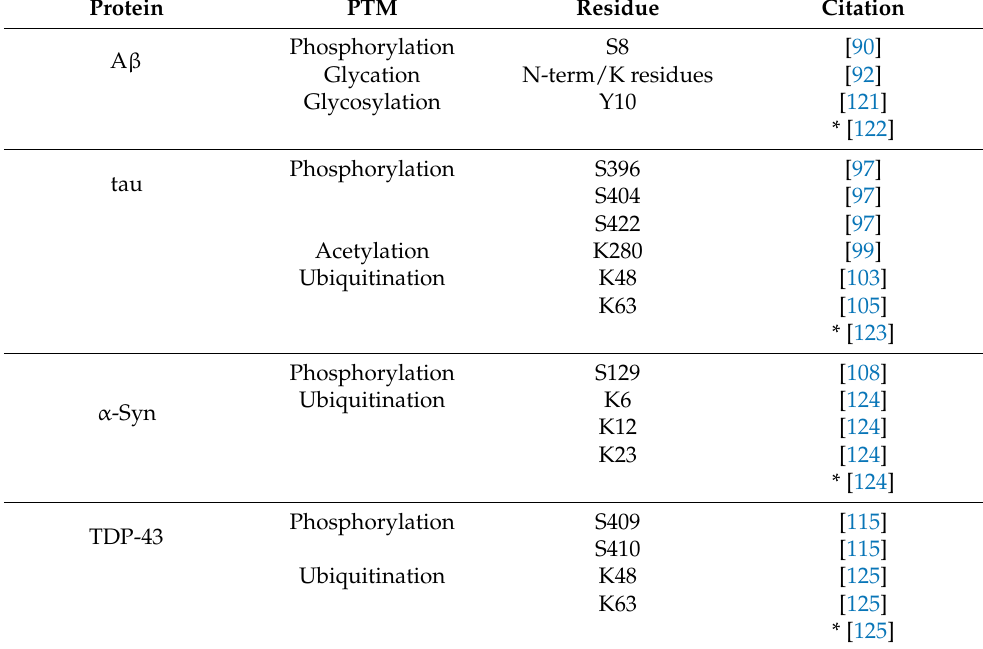
Table 2. PTMs associated with